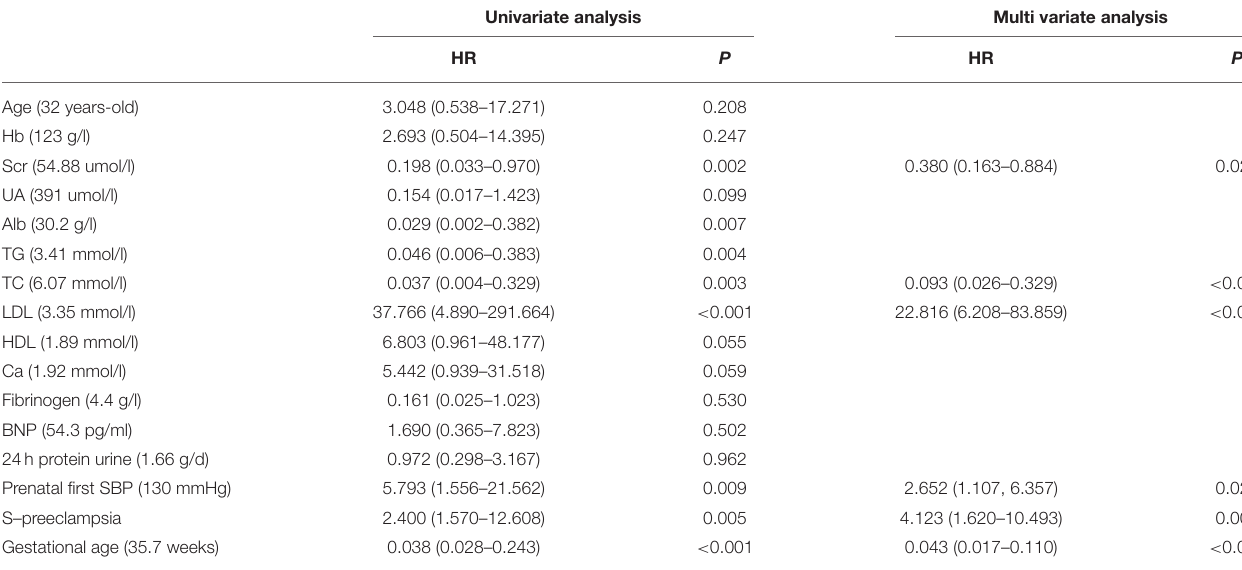
TABLE 2 | Logistic regression analysis risk factors for low birth weight in patients with preeclampsia.